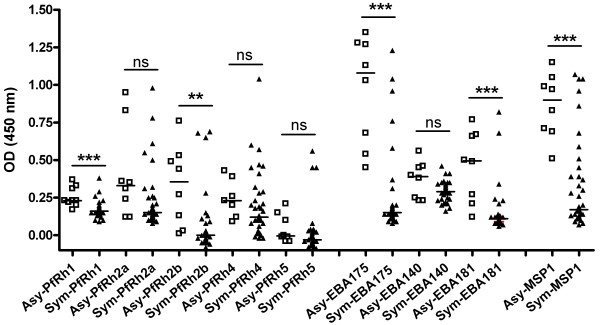
Total IgG responses to EBL and PfRh ligands in Symptomatic and Asymptomatic Peruvian individuals. Comparison between the total IgG responses (as indicated by optical density, OD) in asymptomatic (Asy) and symptomatic (Sym) Peruvian individuals. Median values are indicated by horizontal bars. Abbreviations: Asy, open symbols; Sym, close symbols; ns, not significant; ** p < 0.01; *** p < 0.001.